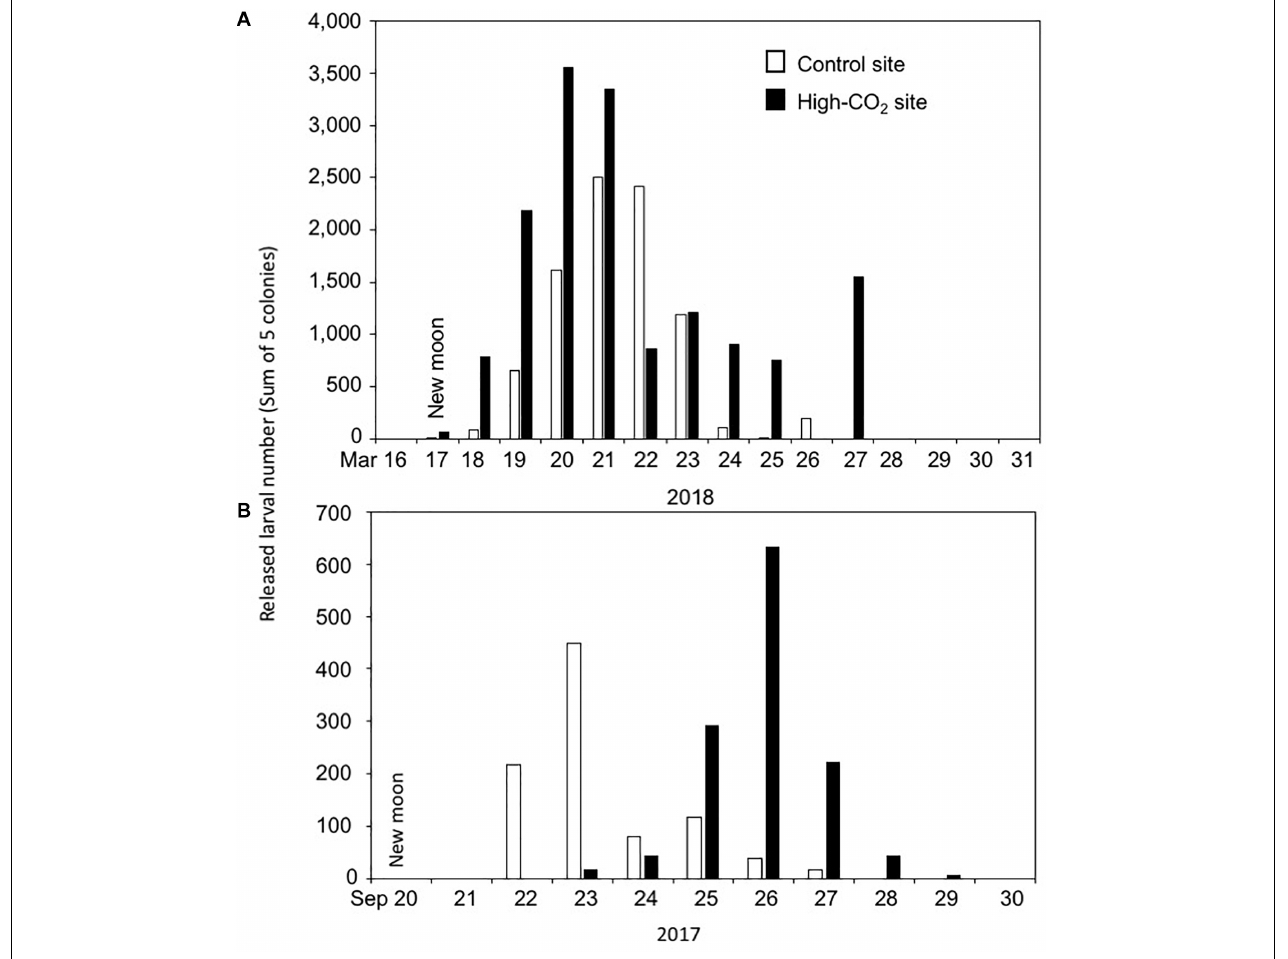
FIGURE 7 | Larval number released each day from the adult corals collected from control and high-CO 2 sites on 2018 (A) and 2017 (B) . Larval number are the sum of 5 colonies collected from each site. Larvae start to be released around the null